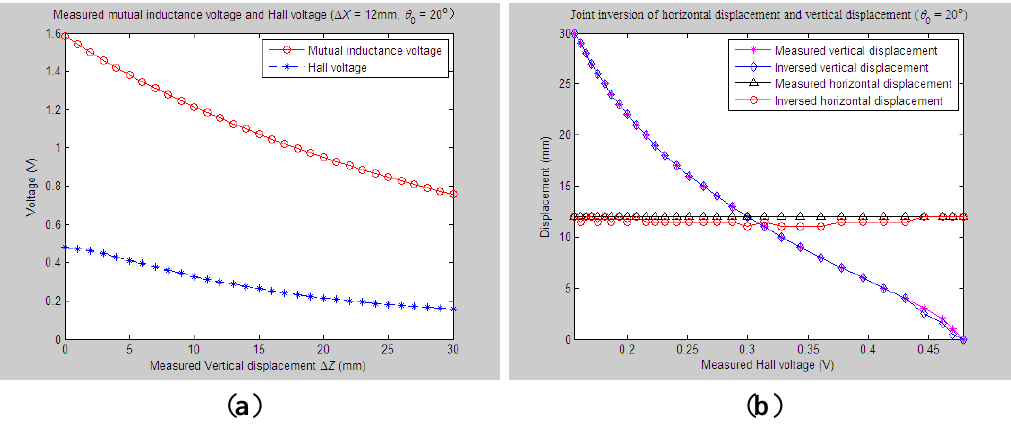
Figure 14. Horizontal and vertical displacement joint inversion results when measured Δ Z are changed, while measured Δ X remain stable ( θ 0 = 20°, Δ X = 12 mm). ( a ) Measured mutual inductance voltage and Hall voltage; ( b ) inversed horizontal and vertical displacements.